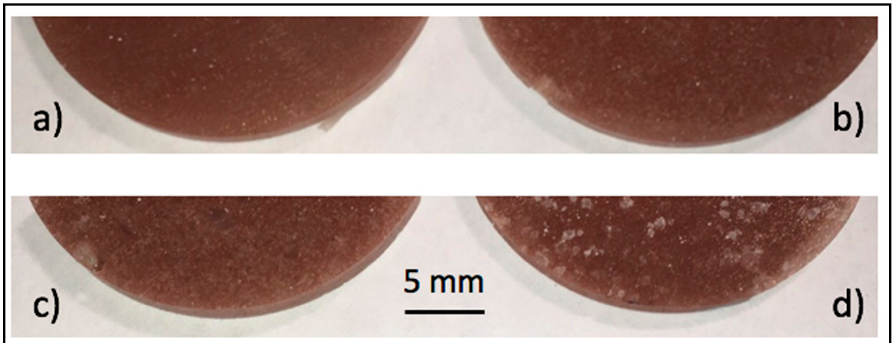
Figure 3. Paraffin dispersion as a function of curing time and loading. Top: Samples with 5% Cu and 5% paraffin. Fillers were added after ( a ) 10 min and ( b ) 20 min of curing time. Bottom: Samples with 10% Cu and 10% paraffin. Fillers included after ( c ) 10 min and ( d ) 20 min of curing time.